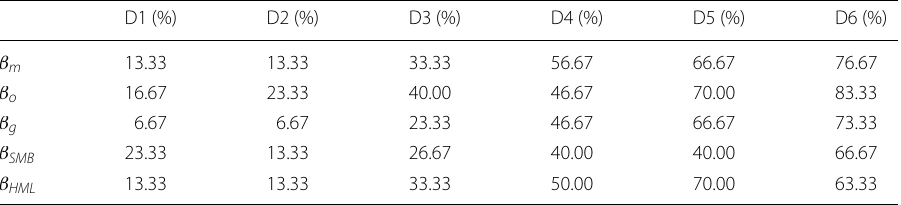
Table 2 Percentages of significantly different Betas between Standard Multi-Betas Model and Time– Frequency Multi-Betas Model